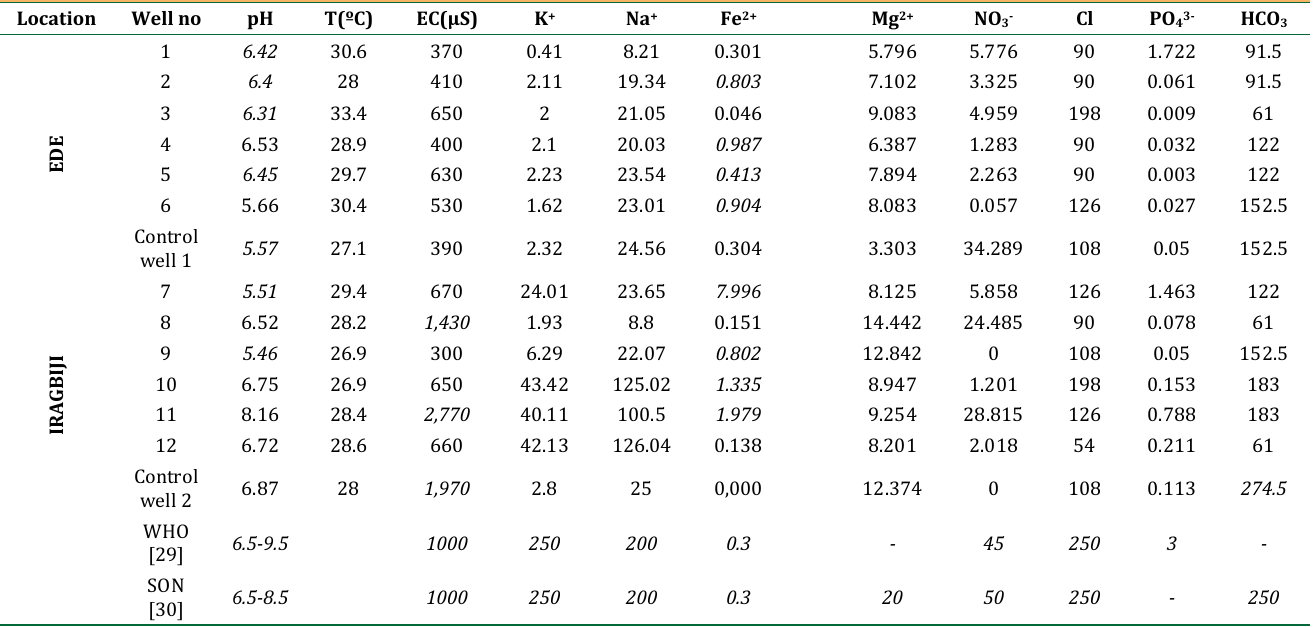
Physio-chemical results of the water samples collected around cemetery at Ede and Iragbiji